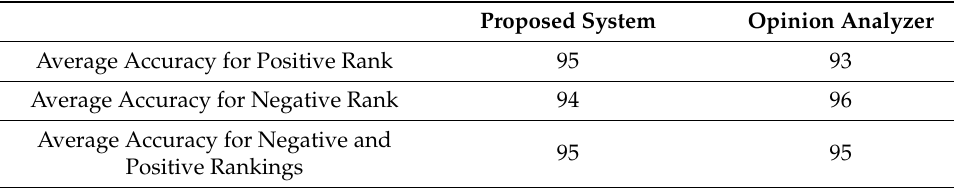
Table 6. Comparison of average accuracy of positive and negative